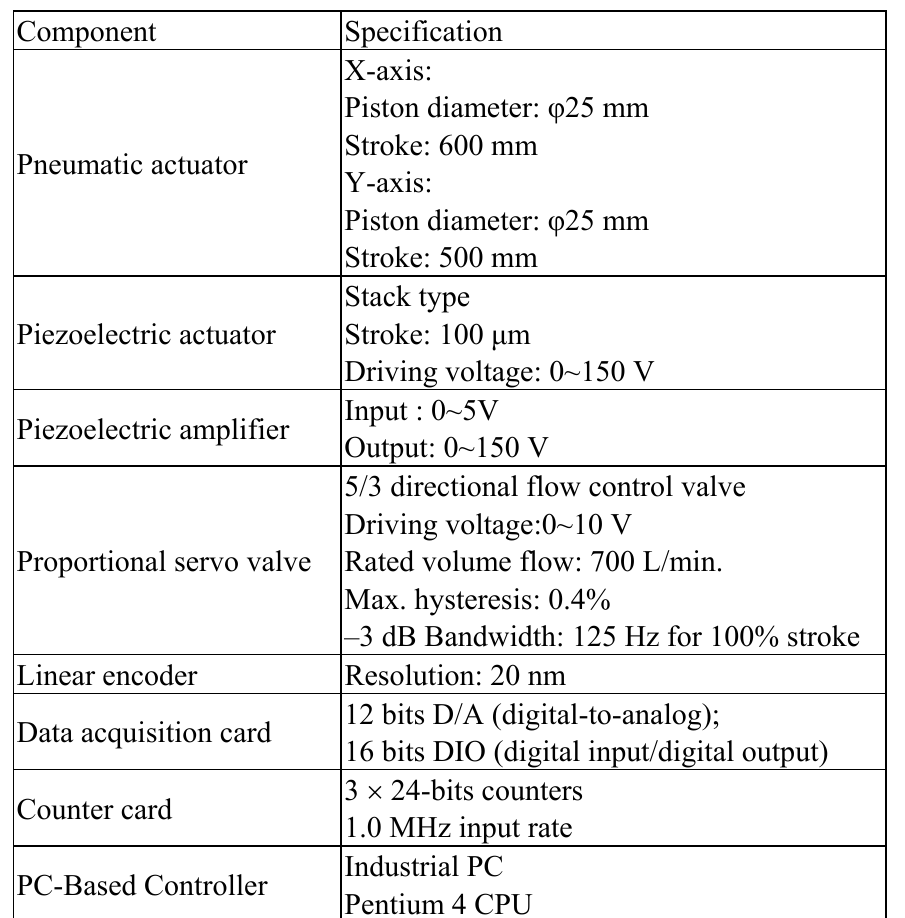
Table 1. Specifications of the main components of the X-Y pneumatic-piezoelectric hybrid actuator.